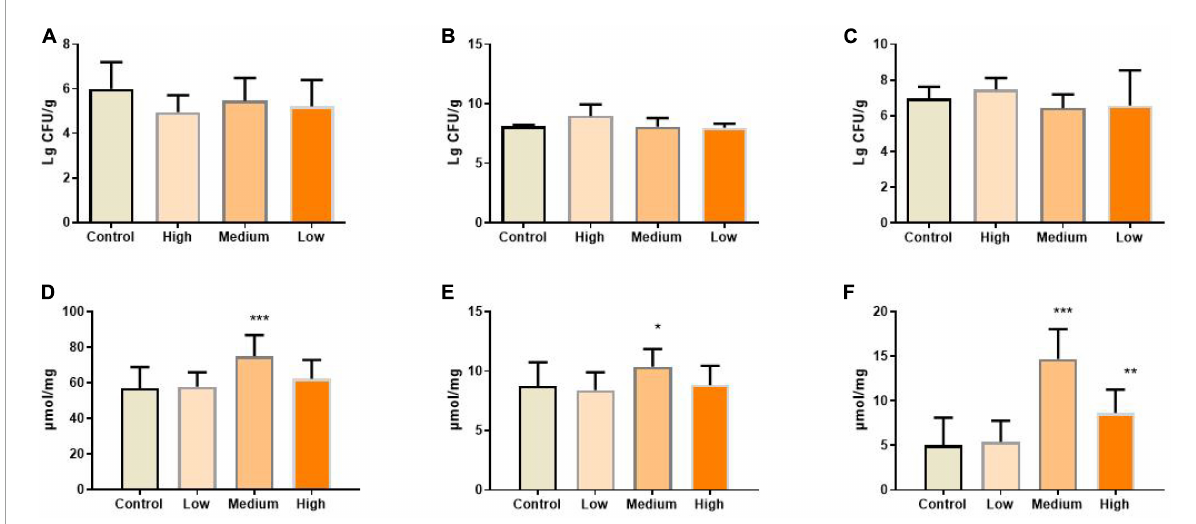
FIGURE8 (A) The amount of Escherichia coli in the content of the intestine was calculated after diluted with 10-fold dilutions of saline from 102 to 107 and cultured in EMB agar medium. It was expressed as. It was reduced by PSP-NP, but showed no significance. (B) Bifidobacteria in the content of intestine was cultured in MRS and the amount of Bifidobacteria was calculated and expressed the same as panel (A) . It was significantly increased in the high dose group of PSP-NP. (C) Lactobacillus in the content of intestine was cultured in BS and the amount of Lactobacillus was calculated and expressed the same as panel (A) . The results showed that PSP-NP improved the amount of Lactobacillus. (D − F) The contents of acetic acid, propionic acid and butyric acid, respectively, were analyzed by GC. They were all remarkably increased, and the middle dose group showed the best activities. Control indicated the control group administrated with saline, and High, Medium, and Low indicated the high, medium and low dose groups administrated with 200/100/50 mg/kg PSP-NP, respectively. Error bars indicated SEM. N = 16. All data were analyzed by SPSS with the one-way analysis of variance (ANOVA) by LSD test, * P < 0.05, ** P < 0.01, *** P < 0.001, compared with the control